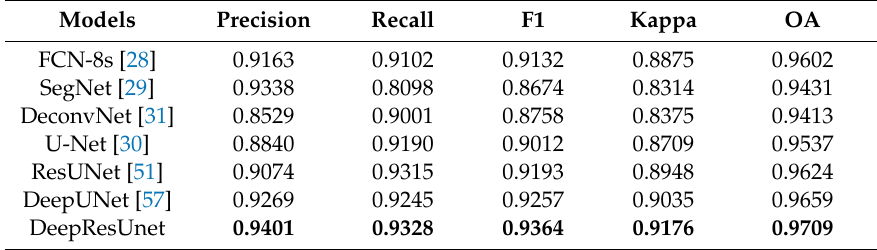
Table 2. Quantitative comparison of five conventionally used metrics obtained from the segmentation results (for an urban area of Christchurch City, New Zealand) by FCN-8s, SegNet, DeconvNet, U-Net, ResUNet, DeepUNet and the proposed DeepResUnet, where the values in bold format are the highest numbers for corresponding